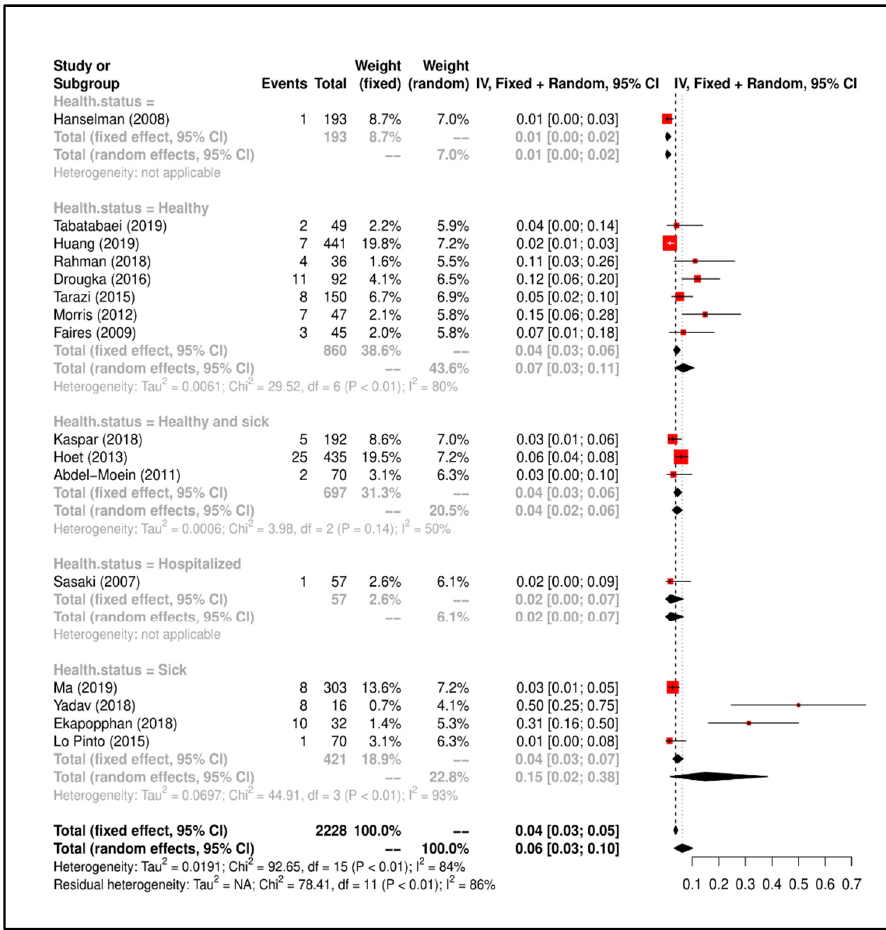
Figure 3. Forrest plot corresponding to the occurrences of S. aureus grouped by “health status of dog”.